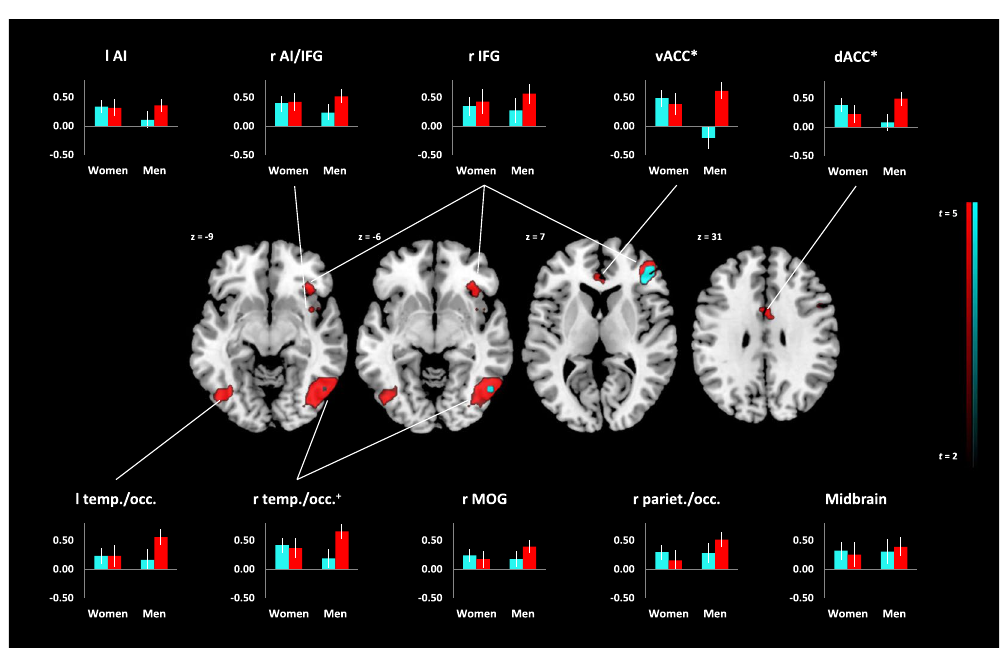
Figure 3. Conjunction Self > Friend & Self > Stranger , whole brain analyses within subsamples (red = high narcissism, cyan = low narcissism.), p FWE < 0.05. Graphs display interaction narcissism * sex in regions of interest, + p < 0.10, * p < 0.05; vertical axes indicate signal change, error bars denote + / − 1 SE of the mean. l = left, r = right. AI = anterior insula, IFG = inferior frontal gyrus, v/dACC = ventral/dorsal anterior cingulate cortex, MOG = middle occipital gyrus. Plane identifiers are in MNI